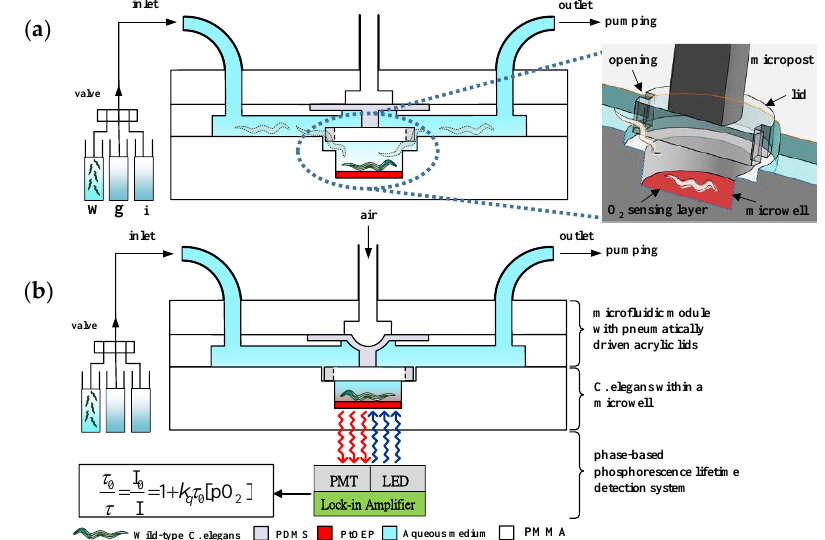
Figure 1. A schematic of a microfluidic device integrated with an optical detection system to measure the oxygen consumption rate (OCR) of a single developing Caenorhabditis elegans ( C. elegans) from the postembryonic development to aging stages in real time via phase-based phosphorescence lifetime measurement. The device consists of two components: an acrylic microwell deposited with an O 2 sensing layer and a microfluidic module with a pneumatically driven acrylic lid to controllably seal the microwell. A single C. elegans in a centrifuge tube (w), the aqueous solution of growth medium in a centrifuge tube (g), or specific metabolic inhibitors in a centrifuge tube (i) was introduced through the inlet of the microfluidic module at a specific point in time via a three-way valve. ( a ) The single C. elegans flowed through and crawled along the microchannel toward the microwell. The rounded acrylic lid with two openings as the access points of the microwell allowed the C. elegans to pass and fall into the microwell (inset image in ( a )). ( b ) The long-term OCR measurement via phase-based phosphorescence lifetime measurement was repeated over time using a periodic three-step operation of refilling the microwell with fresh medium, sealing the microwell, and measuring the oxygen concentration by lowering/raising the acrylic lids. PDMS: polydimethylsiloxane; PMMA: poly(methyl methacrylate; PMT: photomultiplier